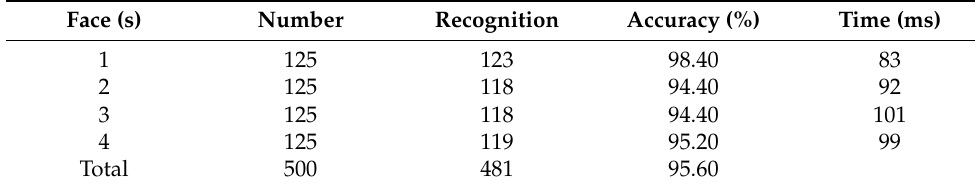
Table 4. Recognition details for multi-face in one